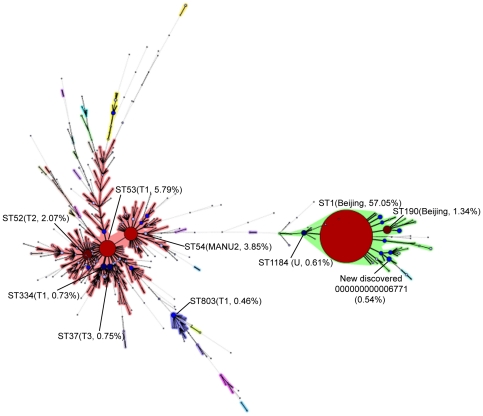
Minimum spanning tree generated with spoligotypes of the respective TB strains from all over the China.Each nodal point represents a particular spoligotype, and the size of nodal point is relative to the number of strains with that spoligotype. The percentage represents the proportion of each spoligotype. The annotations in the figure were the 10 most frequent spoligotypes.